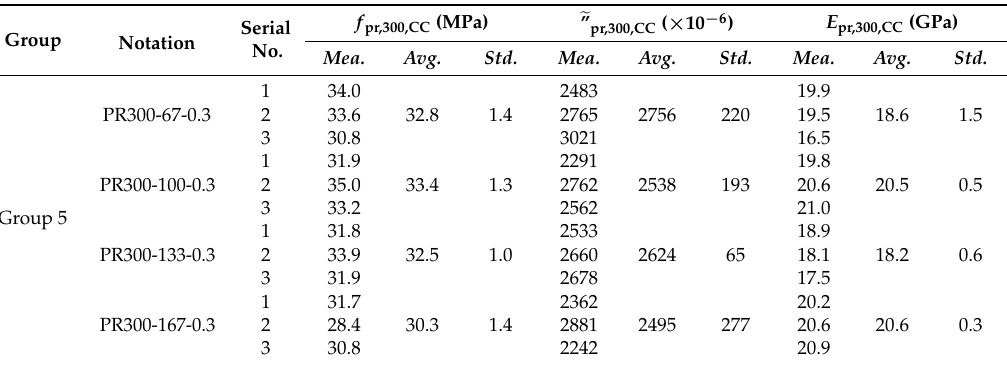
Table 6. Experimental results of specimens in Group 5.